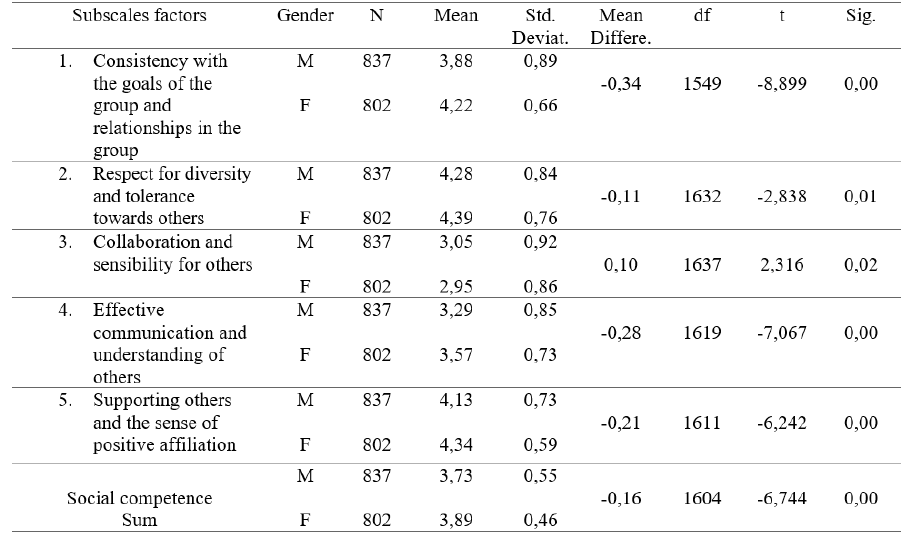
Table 6. Differences in assessments of the development of social competence with regard to the gender of